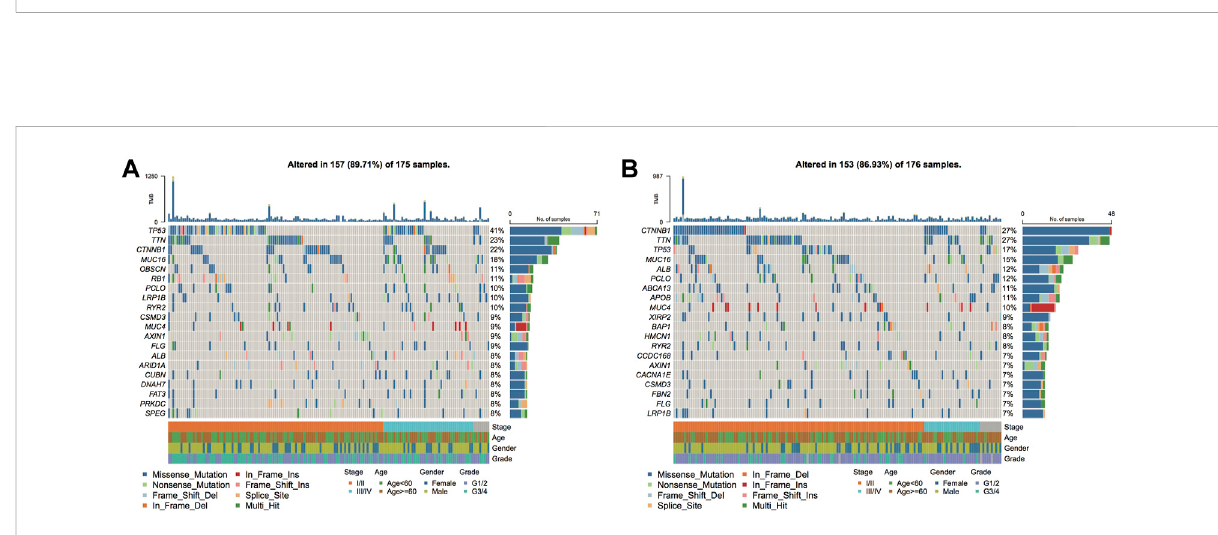
FIGURE 13 Genomic mutationdifferences betweenmodel subgroups. (A) . SNV waterfall plot of TOP20 (mutation frequency)genes in the high-risk group; (B) . SNV waterfall plot of TOP20 (mutation frequency) genes in the low-risk